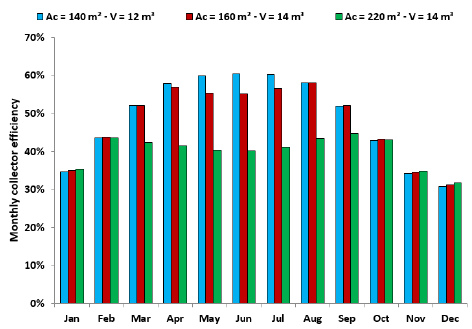
Figure 10. Monthly system efficiency for optimum cases ( A c = 140 m 2 – V =12 m 3 , A c = 160 m 2 – V = 14 m 3 , A c = 220 m 2 – V = 14 m 3 ).